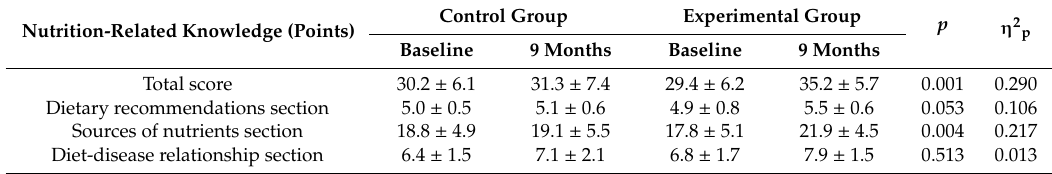
Table 5. Nutrition-related knowledge (total and per section) in two evaluation moments in both